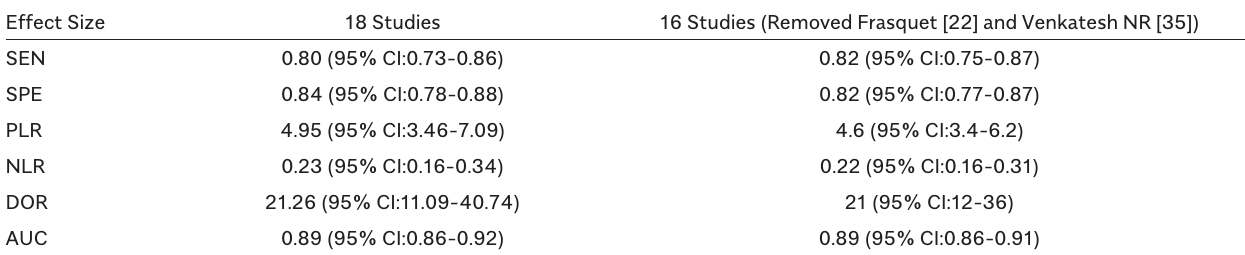
Table 2. Diagnostic Performance of PCT After Removing the 2 Weight